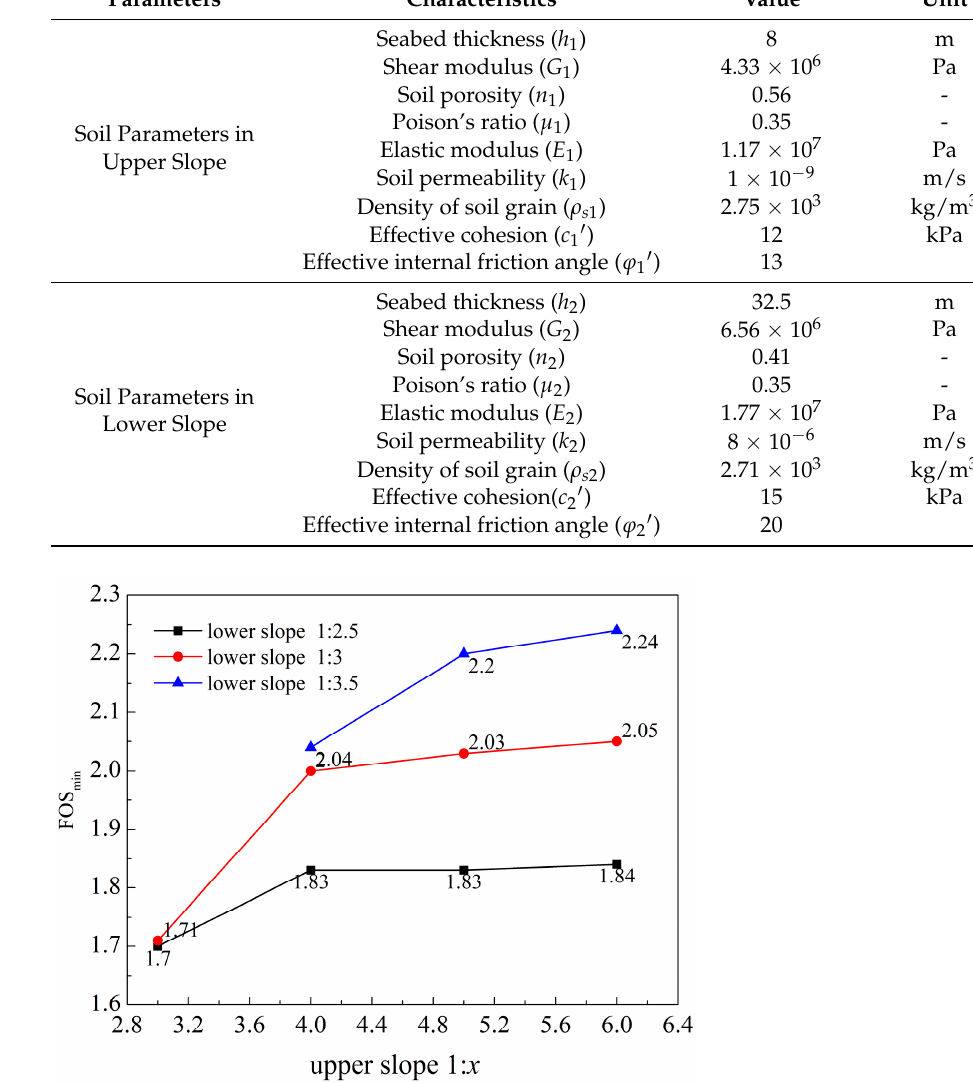
Figure 11. Variation of FOS min with the slope ratio of upper slope for various lower slope ratios.